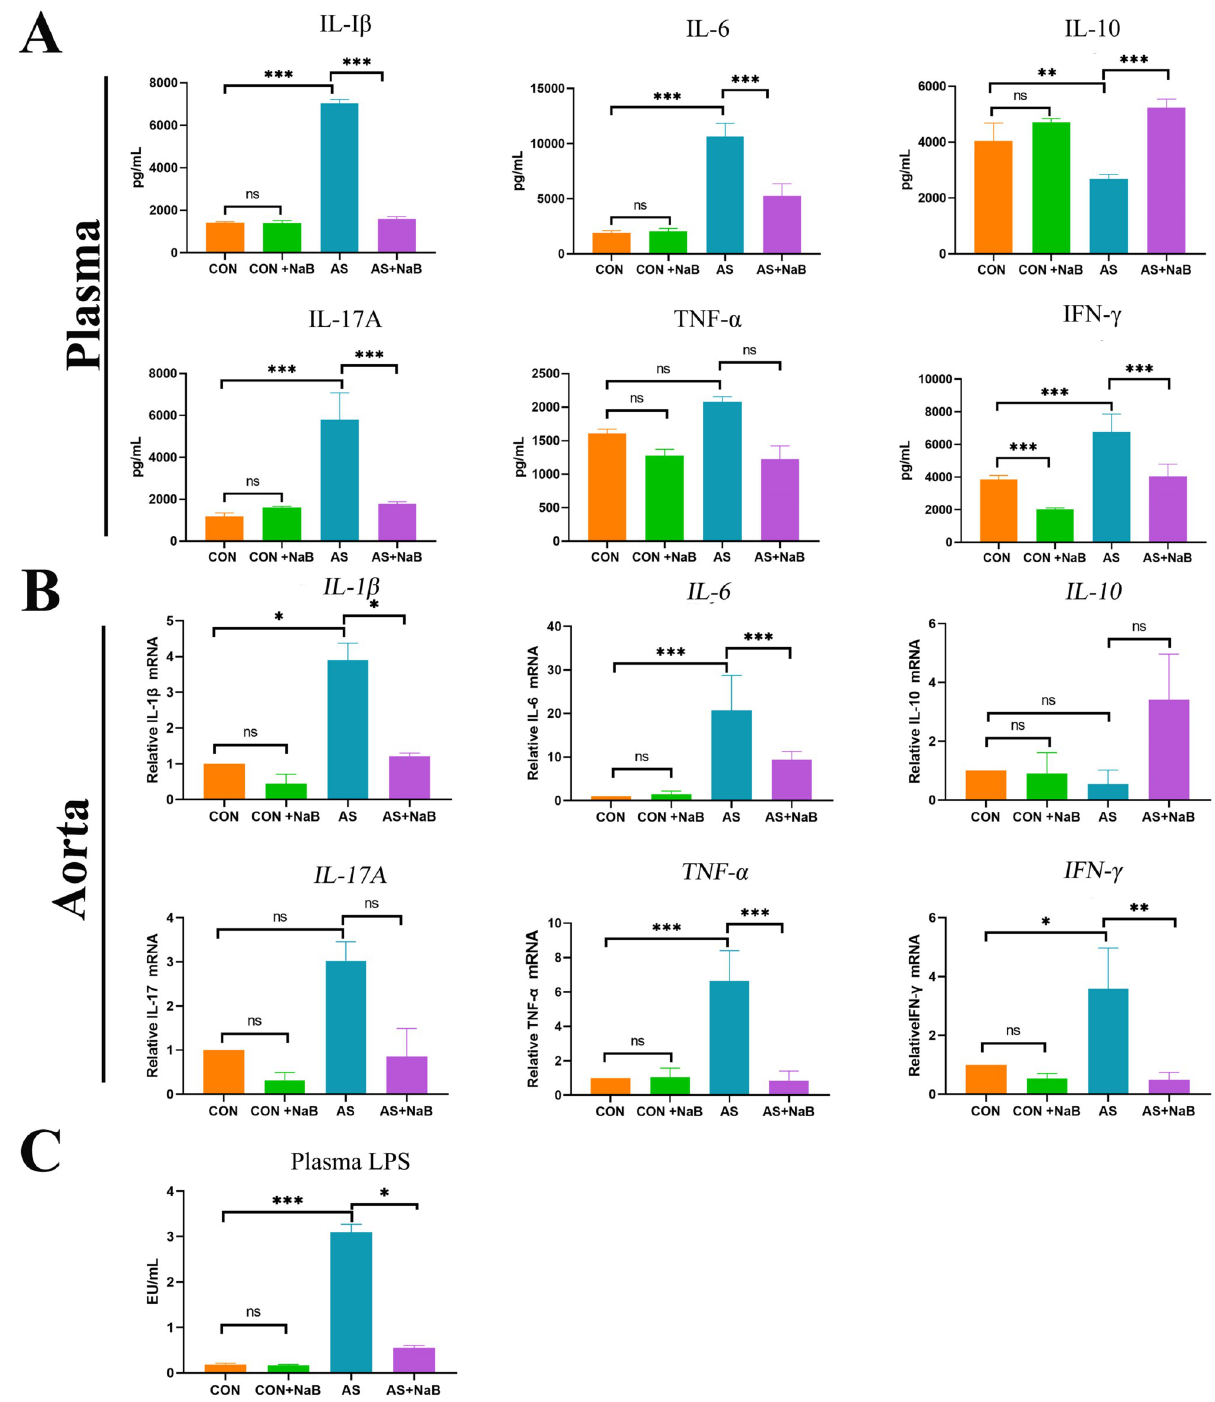
Fig 3. Dietary NaB significantly reduced chronic inflammation in AS. (A) Plasma of mice from 4 groups were respectively collected for the determination of interleukin (IL)-1 β , IL-6, IL-17A, IL-10, tumor necrosis factor (TNF)- α , interferon (IFN)- γ by RayBiotech chip detection. (B) RT-PCR was used to determine relative mRNA levels of IL-1 β , IL-6, IL-17A, IL-10, TNF-a, and IFN- γ in aorta tissues. (C) Plasma lipopolysaccharide (LPS) levels in diverse groups were measured using a Limulus amebocyte lysate kit. � P < 0.05, �� P < 0.01, ��� P < 0.001. ns, no significant difference.